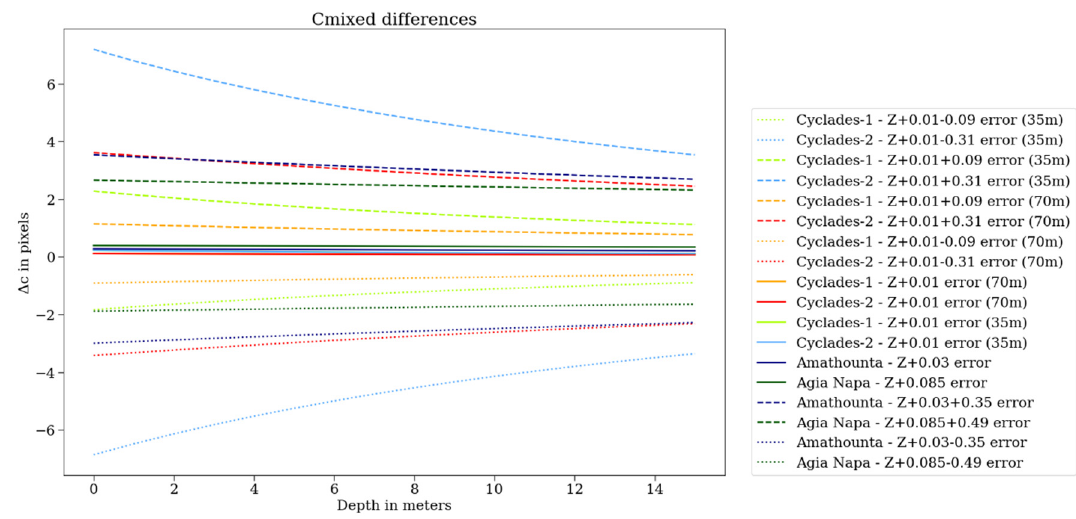
Figure 11. The computed radial distance differences and the c mixed differences for all the test sites.